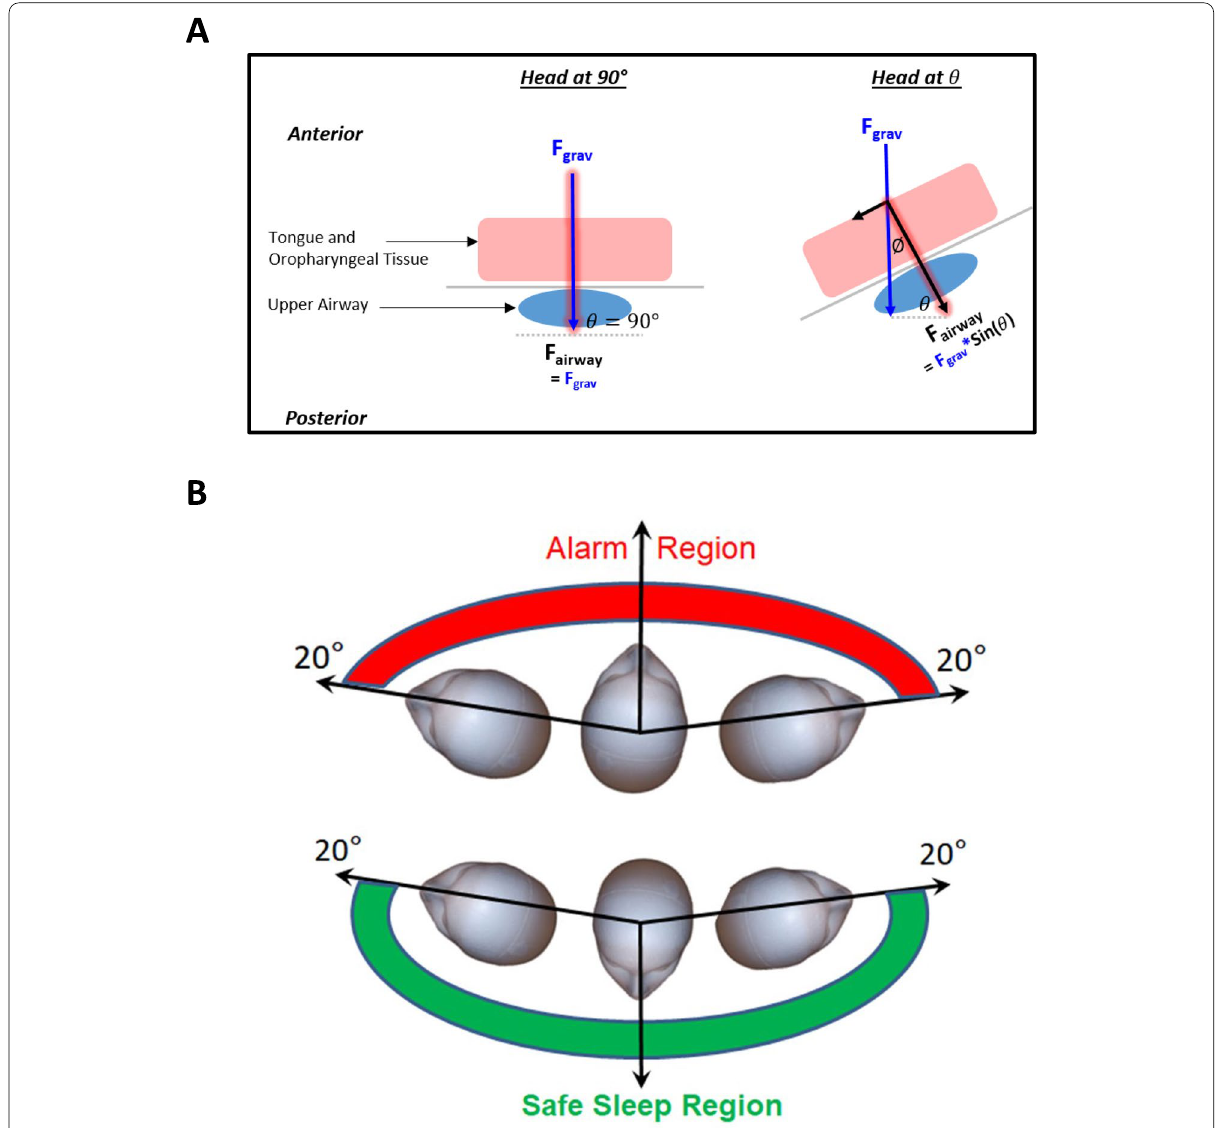
Fig. 4 Force of gravity acting on oropharyngeal tissue to compress upper airway when head is supine compared to laterally rotated head ( A ). Proposed “Safe Sleep Region” of head rotation angles to reduce apnea - hypopnea index in positional OSA patients ( B